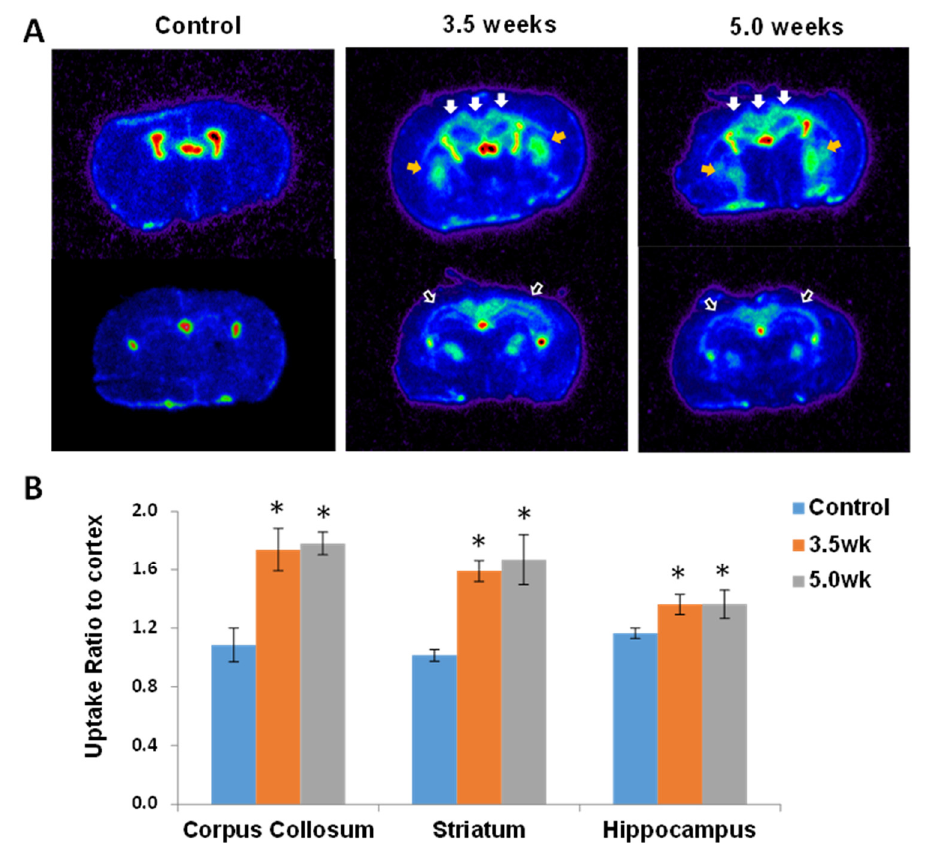
Figure 5. ( A ) 18 F-PBR-111 autoradiography images of control, 3.5, and 5.0 week cuprizone fed (CF) mice. ( A ) Autoradiography of two brain sections were taken from each mouse to capture the uptake in regions of interest. There was minimal uptake in the control mouse brain, but a strong uptake in the corpus callosum (white arrows) and striatum (orange arrows) at the level of the fornix and the hippocampus lying inferior to the corpus callosum (empty arrows) more posteriorly in 3.5 and 5.0 week CF mice. ( B ) Uptake in these regions were normalized to the cortex, which served as reference tissue. The uptake ratio to cortex for all three regions were significantly higher in the 3.5 and 5.0 week mice compared to controls (*, p < 0.05), but no significant difference between the 3.5 and 5 week